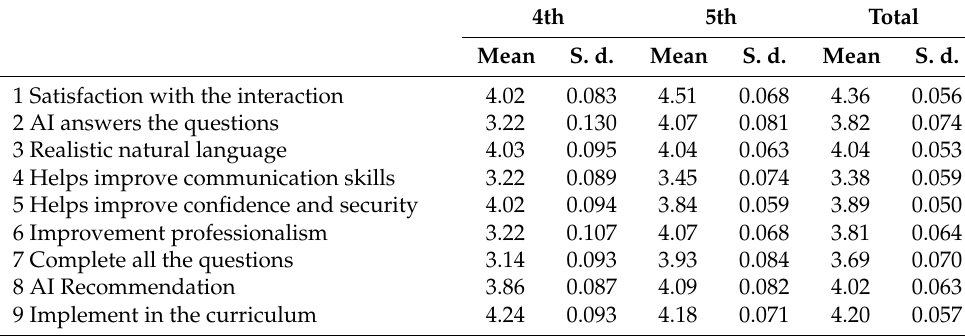
Table 5. Descriptive statistics by item.